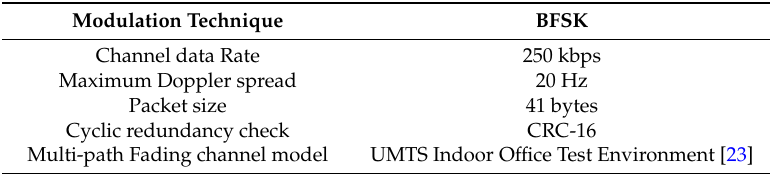
Table 7. Simulation parameters with Matlab.